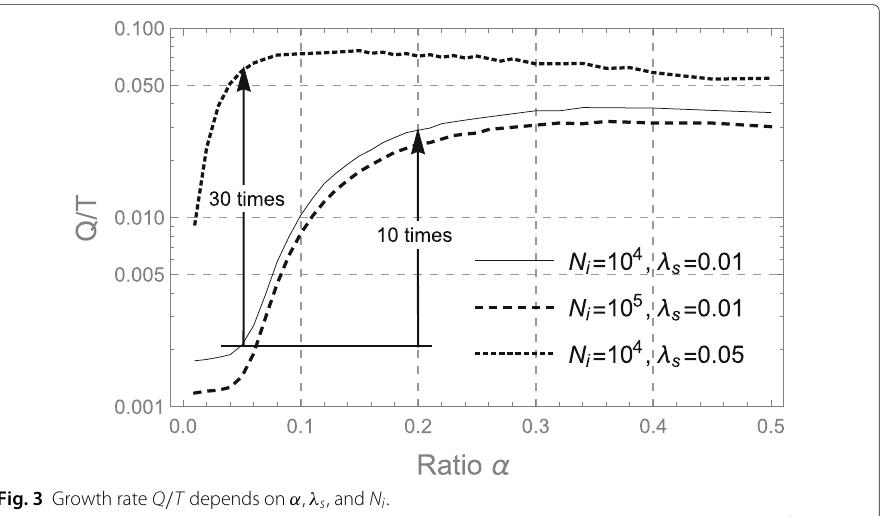
Fig. 3 Growth rate Q / T depends on α , λ s , and N i